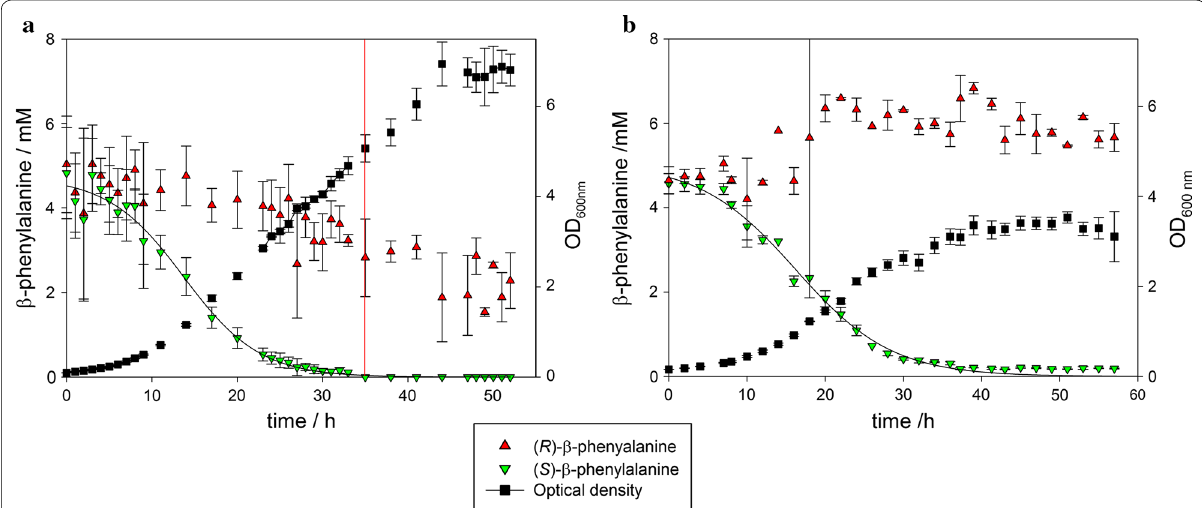
Fig. 1 Degradation of rac ‑β‑phenylalanine by Paraburkholderia sp. in a 2.5 L bioreactor. The fermentation was conducted in triplicate at 30 °C in 1 L minimal medium M1 with 10 mM of rac ‑β‑PA. a BS115, b PsJN. The red line indicates ( S )‑β‑PA <